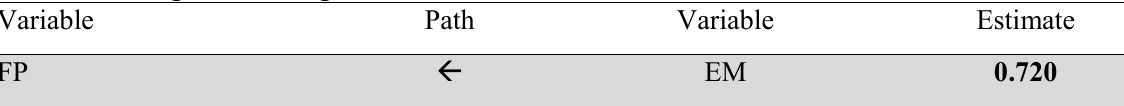
Standardized Regression Weights of EM on FP